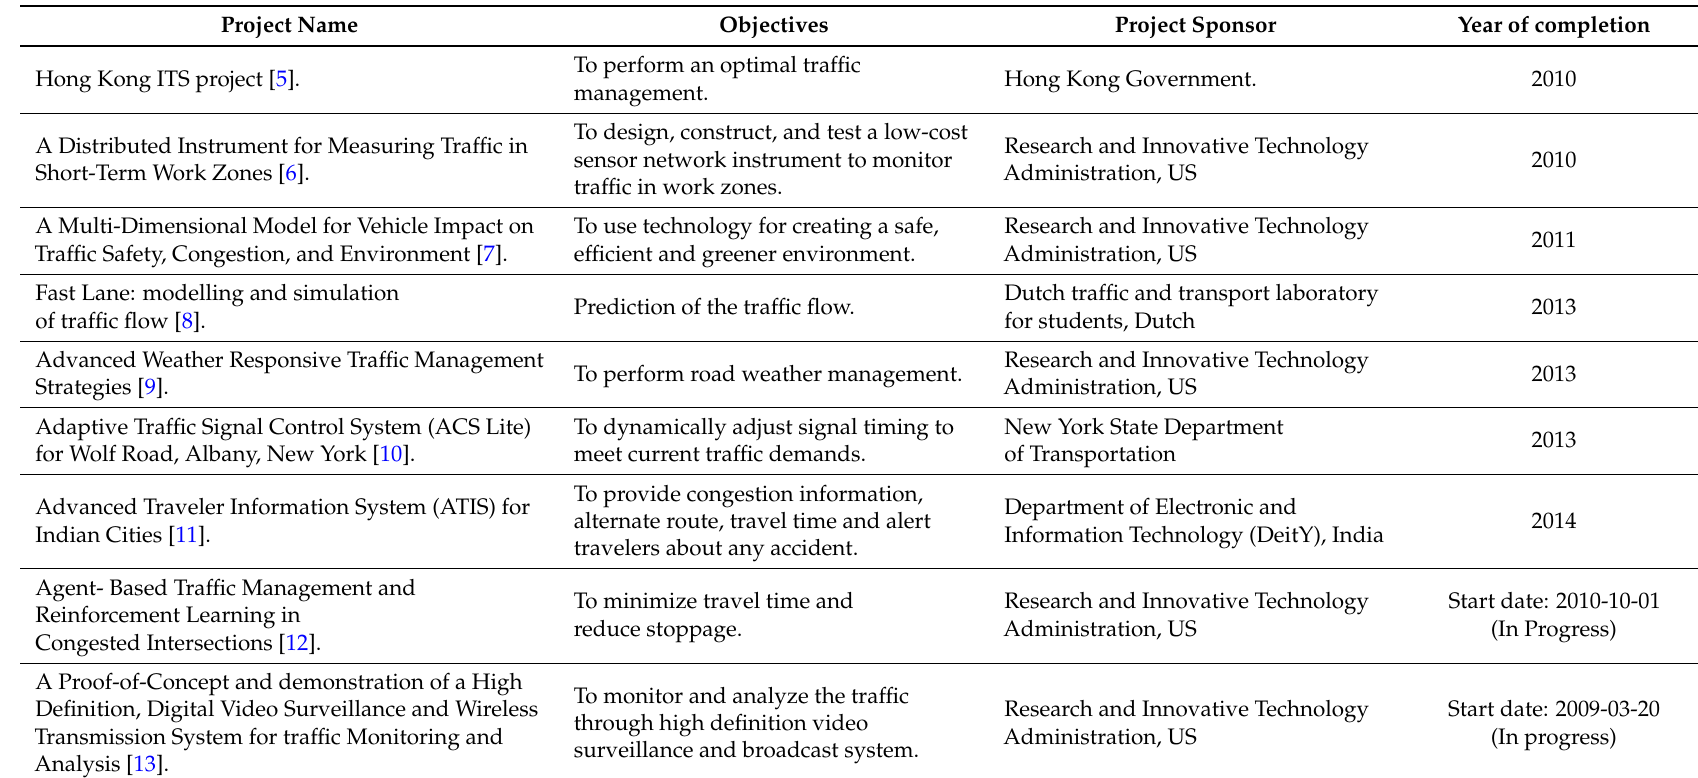
Table 4. Urban Traffic Management